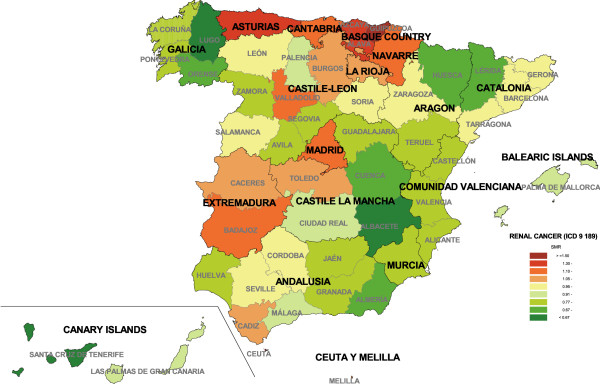
Provincial distribution of kidney cancer mortality: Spain, 1989–1998.